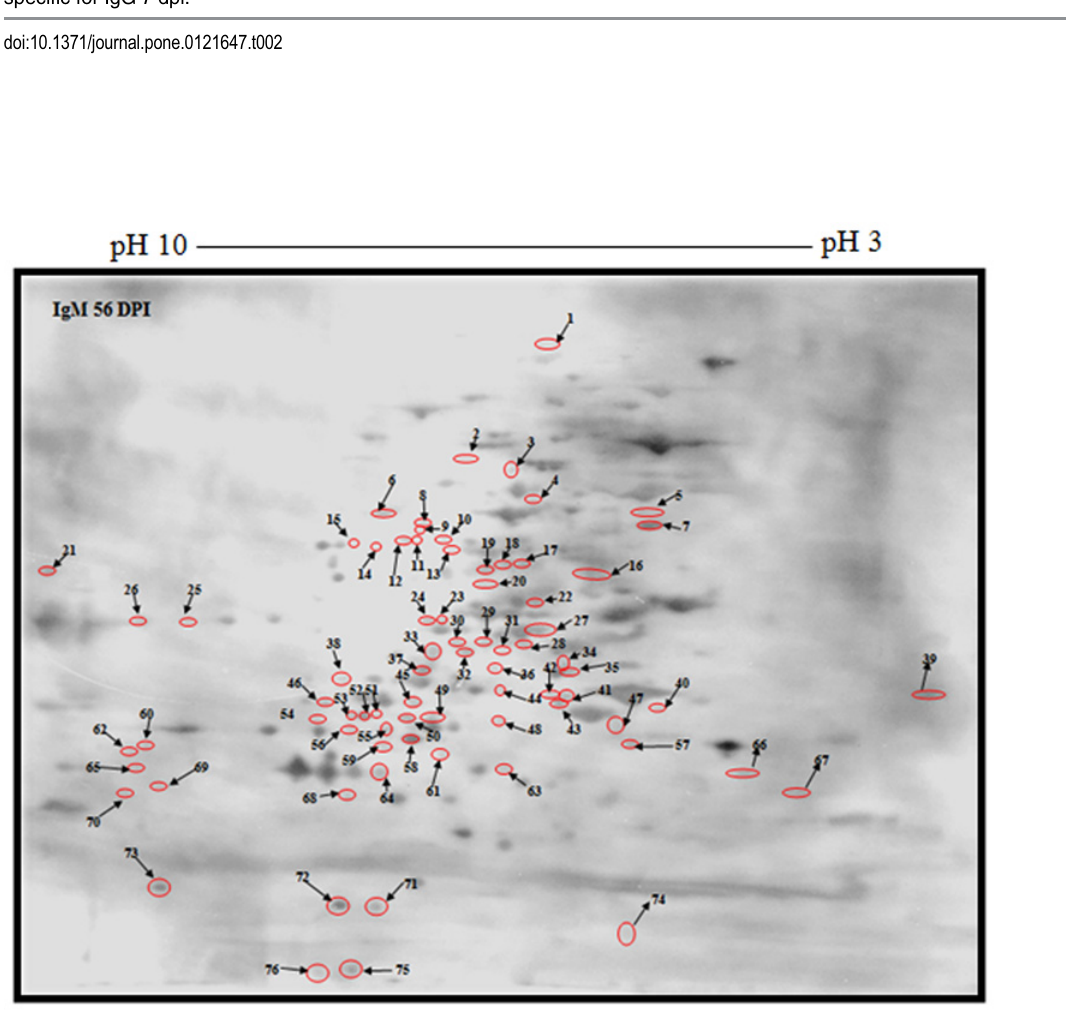
Fig 7. Immunoblot picture of unique reactive polypeptide spots of 2-DE separated T . gondii strain RH tachyzoite proteins using antibodies specific for IgM 56